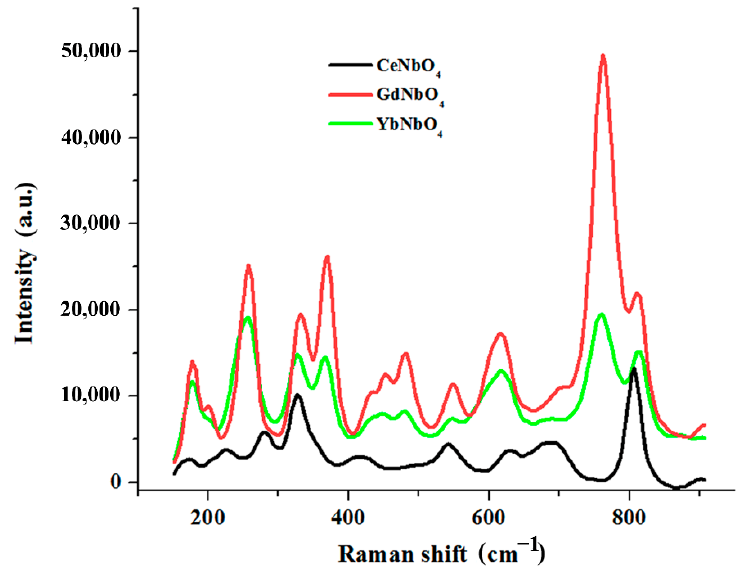
Figure 10. Raman spectra of the heterovalent ionic substitution reaction products formed by the interaction of the LiNbO 3 powders with molten LiCl-LnCl 3 (Ln = Ce, Gd, Yb) mixtures at 700 ◦ C.